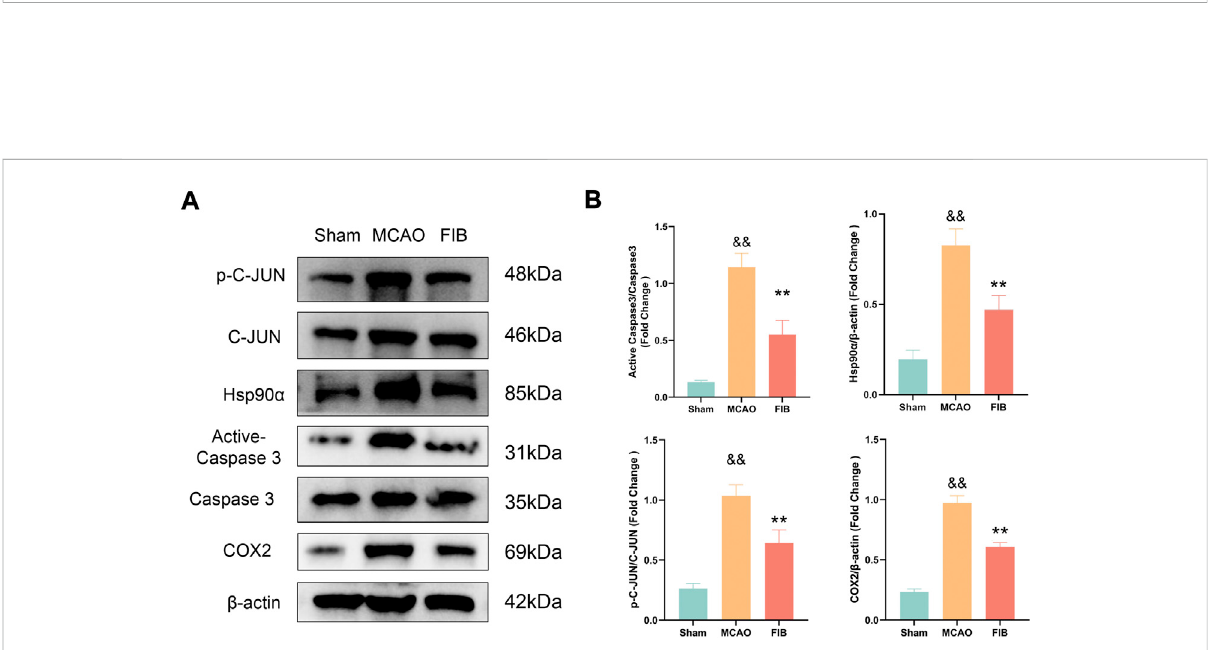
FIGURE 11 The effect of FIB on the expression levels of Caspase3, HSP90AA1, C-JUN and COX2 in MCAO mice was detected by Western Blot (A and B) . && p < 0.01, vs. the sham group. * p < 0.05, ** p < 0.01, vs. the MCAO group ( n =